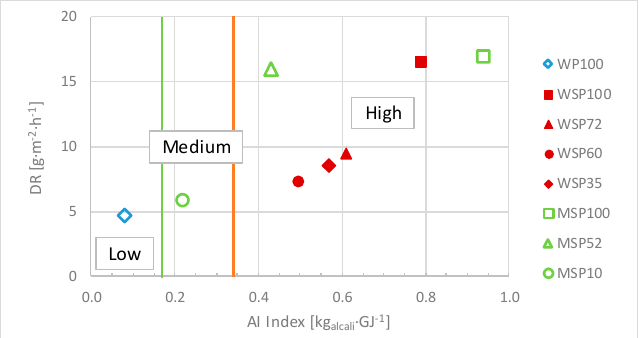
Figure 17. AI index versus average deposition rate for each fuel.